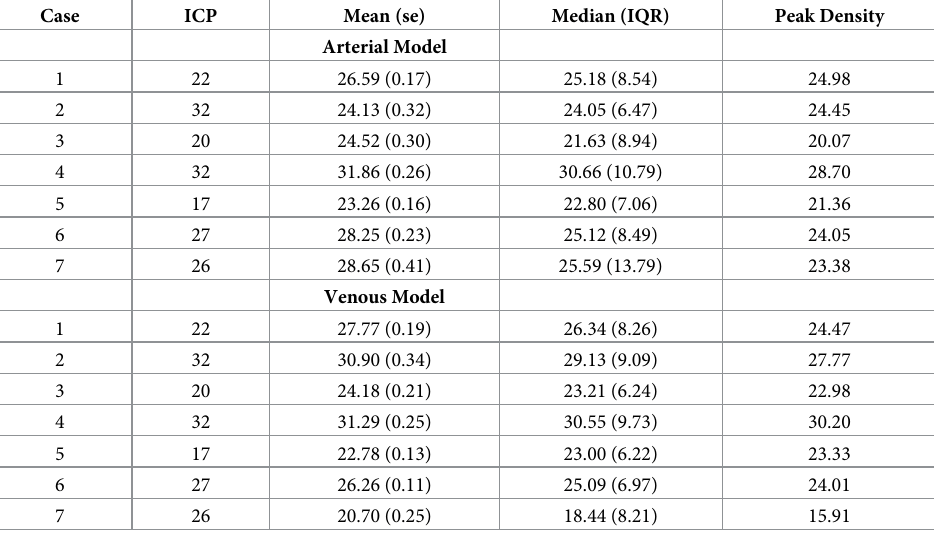
Table 5. Hold-out test set comparing measured and predicted ICP (cm water) using the XGB models for both the arteries and